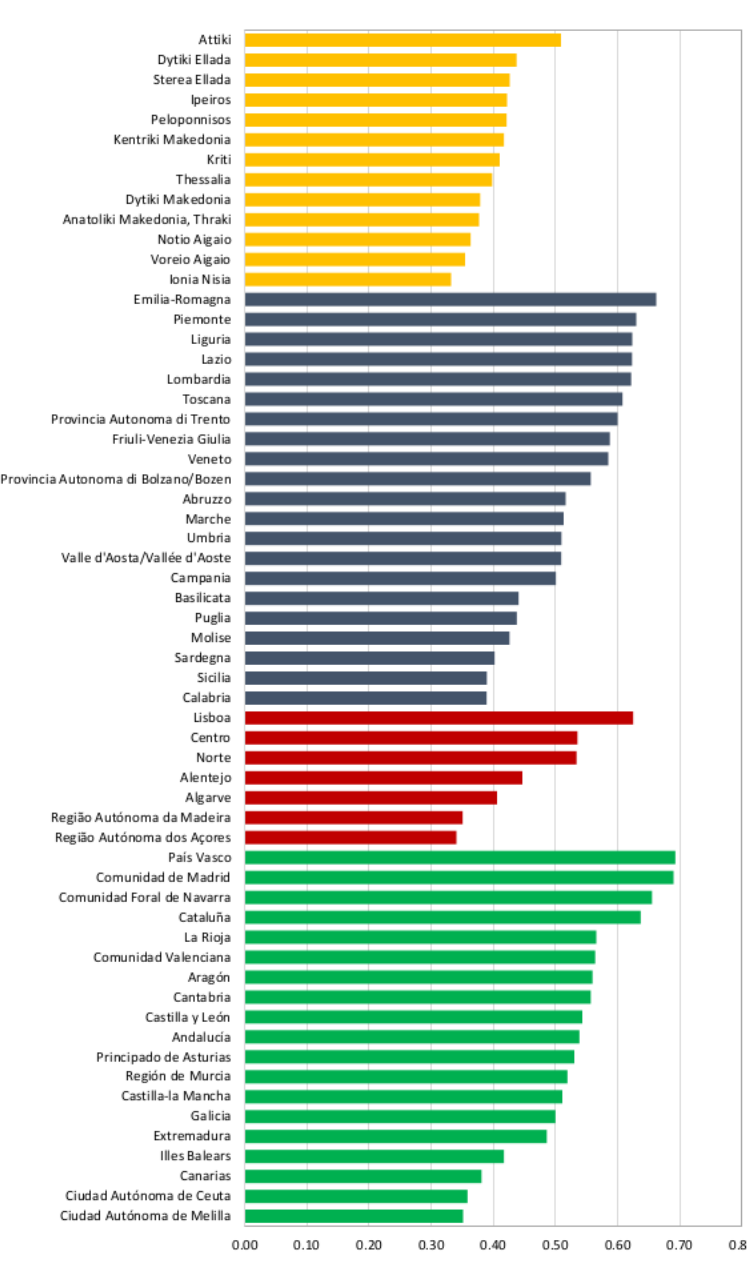
REGION : Volume 3, Number 2,